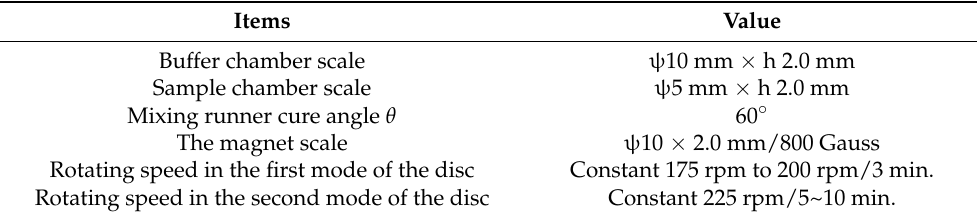
Table 3. Optimal operator conditions for controlling the magnetic and non-magnetic particles flowing and separating in the runner of the disc. Items Value Buffer chamber scale ψ 10 mm × h 2.0 mm Sample chamber scale Mixing runner cure angle θ 60 ◦ The magnet scale ψ 10 × 2.0 mm/800 Gauss Rotating speed in the first mode of the disc Constant 175 rpm to 200 rpm/3 min. Rotating speed in the second mode of the disc Constant 225 rpm/5~10